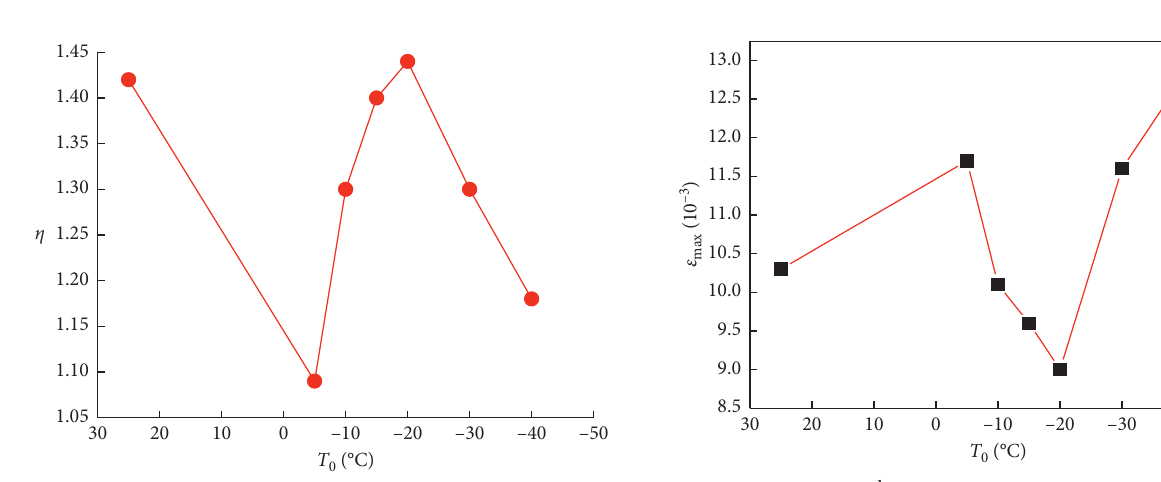
Figure 12: Variation of the dynamic compressive strength factor with temperature. Figure 13: Variation of peak strain with the temperature of sat- urated